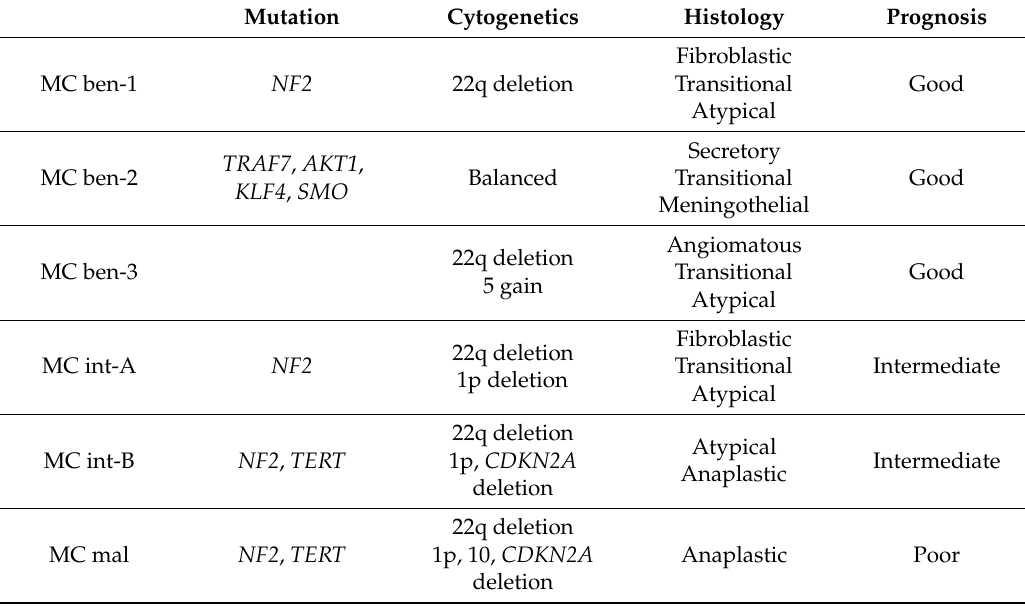
Table 6. DNA methylation-based grading system for meningioma. Data are reported in Sahm et al., 2018